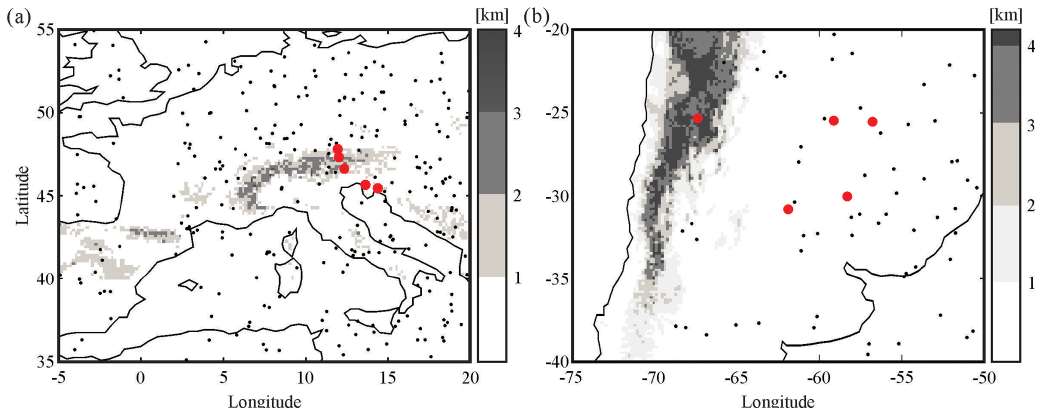
Figure 2. Collocated events between GPS RO profiles and convective systems in (a) the Alps region and (b) the Andes region. The latitude and longitude corresponding to the mean tangent point belonging to each RO are located within a radius of 100km with respect to the center of the storm and in a time interval less than 3h. Events considered in this study are indicated in